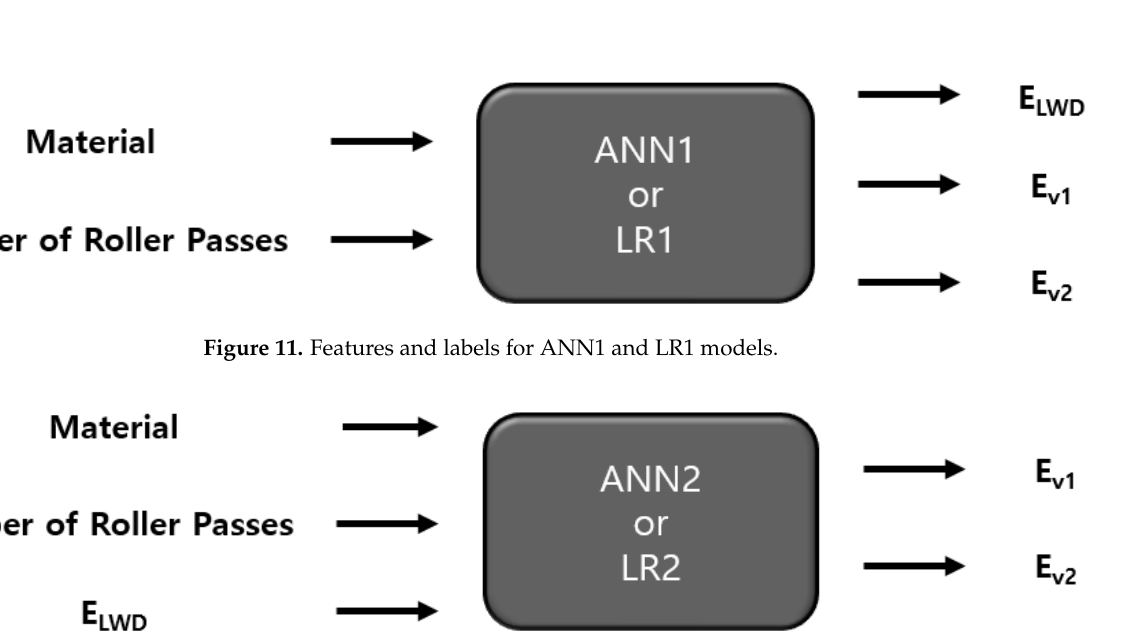
Figure 12. Features and labels for ANN2 and Linear Regression 2 (LR2) models.